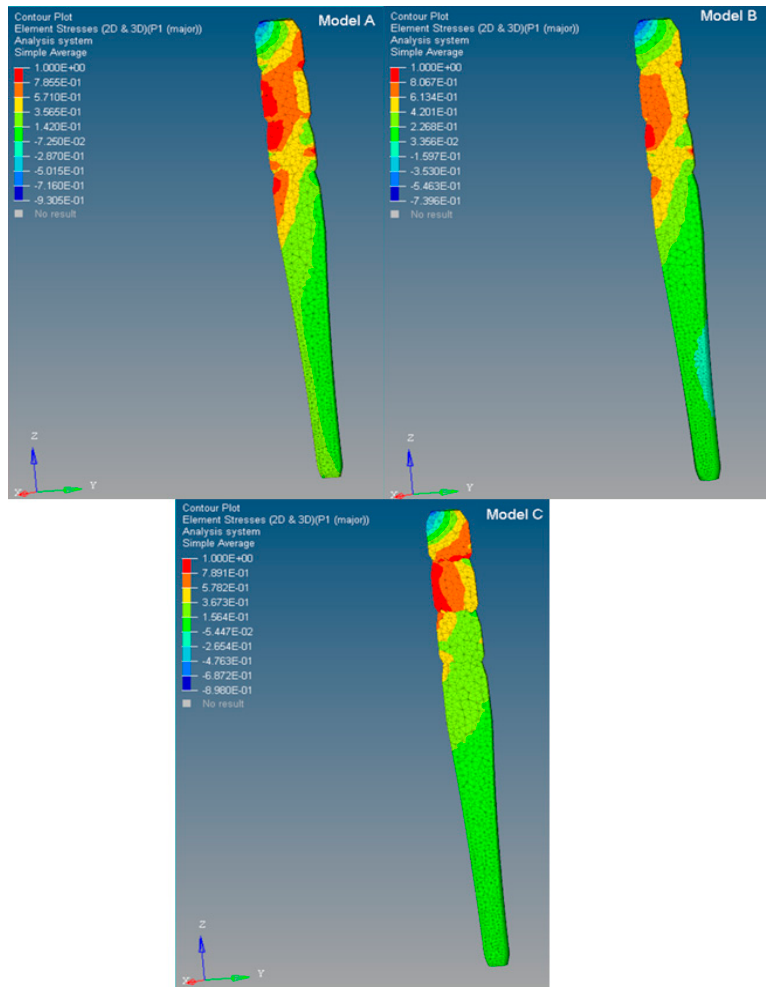
Figure 3. Maximum principal stress distribution (MPa) along the post in the restored tooth models ( A , B, and C ): mid-plane section.